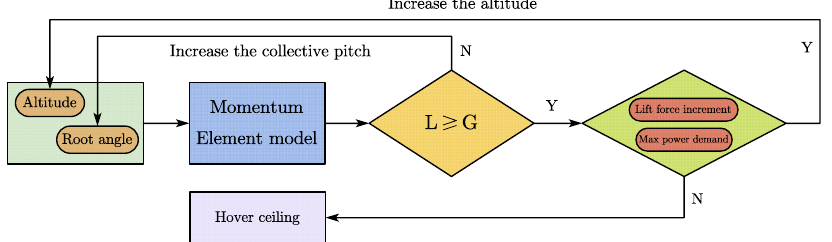
Figure 7. Hover ceiling calculation flow.